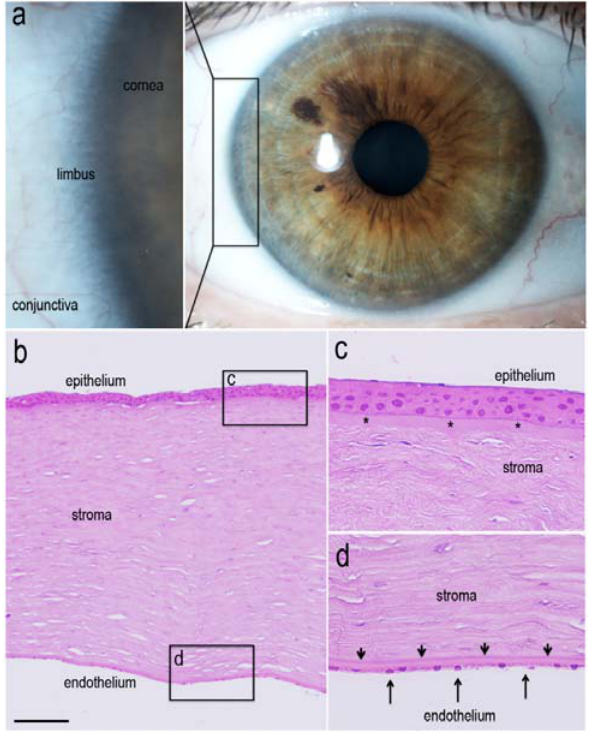
Figure 1. The corneal limbus is the circumferential anatomic area, approximately 1.5 mm wide, which separates the clear cornea from the opaque sclera ( a ); The limbal region represents the “reservoir” for LSCs in the ocular surface. In a cross-section of the human cornea stained with hematoxylin-eosin, ( b ) to ( d ), details of its main layers can be observed. The cornea is composed of a stratified non-keratinized squamous epithelial layer (epithelium), the stroma and an endothelial cuboidal layer (endothelium) ( b ); The corneal epithelium (48 to 55 µm thick) consists of the outermost layer, which presents five to seven stratified cell layers ( c ), limited posteriorly by Bowman’s layer (10 to 12 µm thick; c, asterisk). The stroma (480 to 510 µm thick; b), composed of compacted collagen lamellae and keratocytes (c and d), offers transparency and scaffolding to maintain the shape of the cornea in its middle portion. The stroma is separated from the endothelium (about 5 µm thick; d, large arrows) by Descemet’s membrane (8 to 10 µm thick; d, narrow arrows), which acts as a basement membrane for the corneal endothelial cells ( d ). Bar = 150 µm for b; Bar = 25 µm for c and